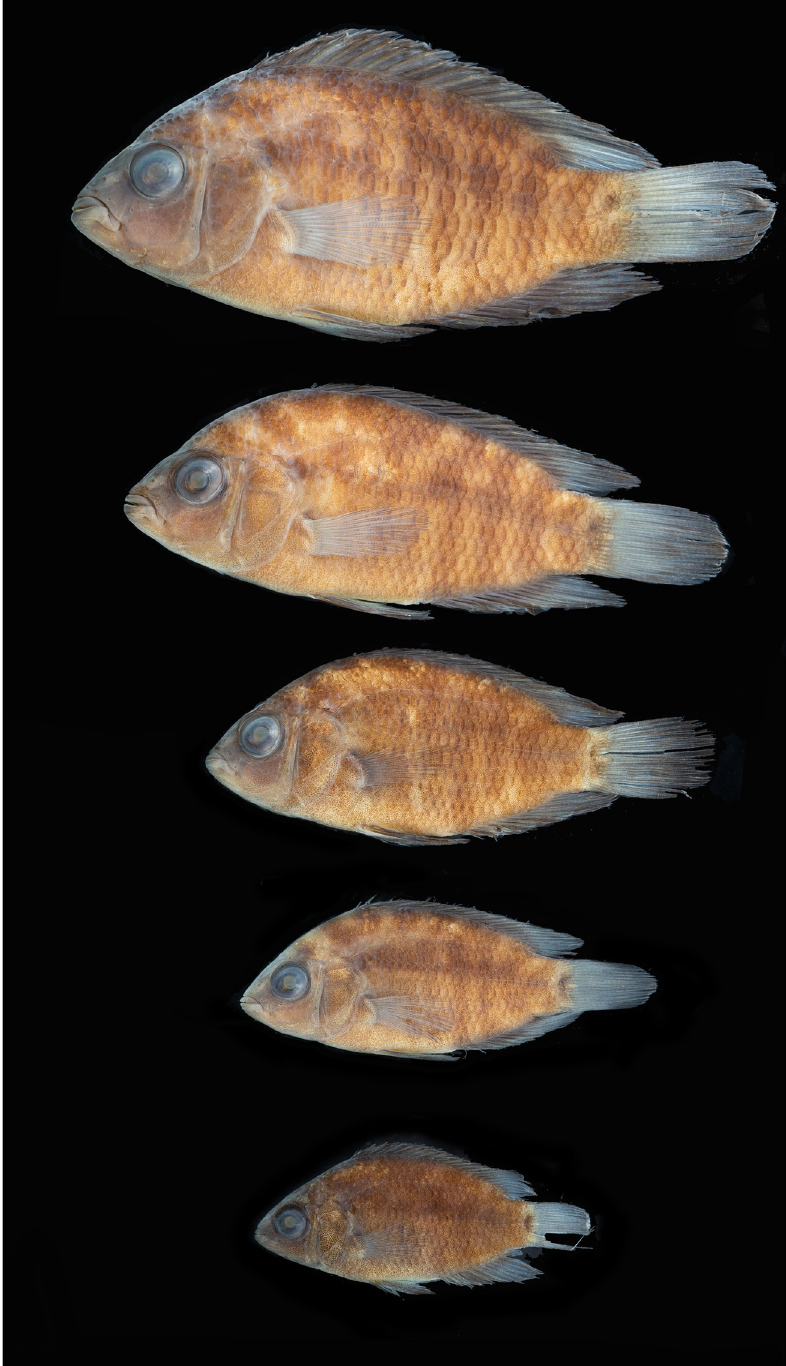
Fig 16. Australoheros facetus , ontogenetic series; from bottom to top 23.8–45.3 mm SL; NRM 54218; Uruguay; Maldonado: Laguna del Diario.